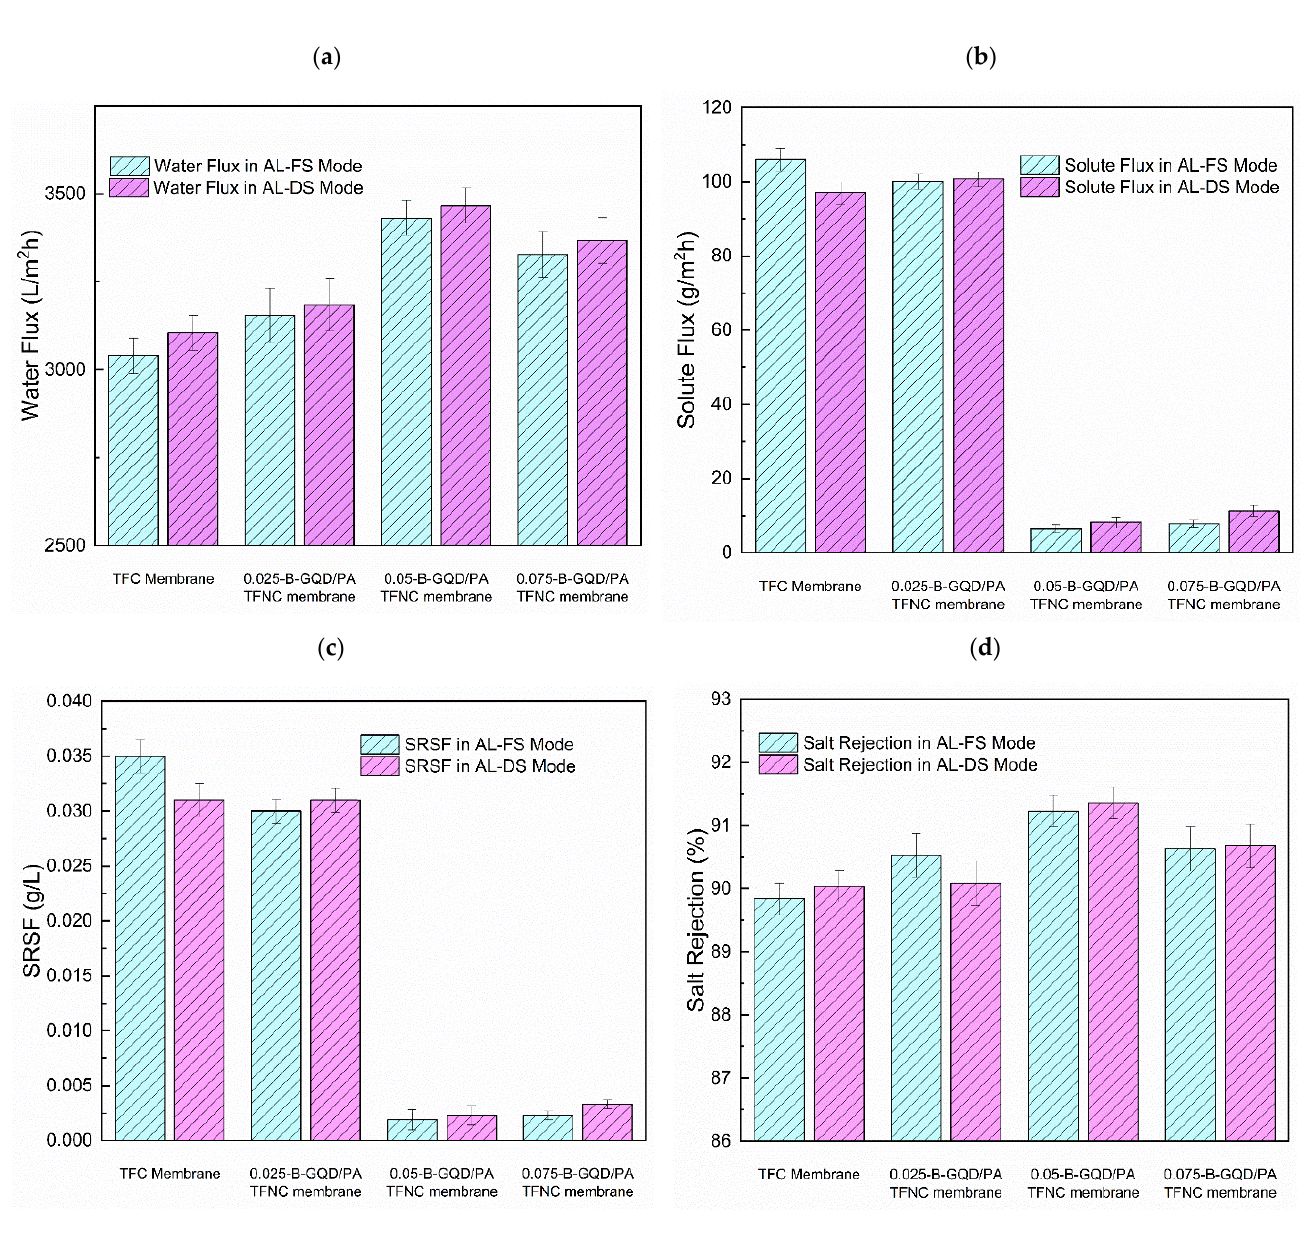
Figure 10. ( a ) Water flux of the TFC and TFNC membranes in the AL-DS and AL-FS orientations at varying B-GQD concentrations; ( b ) salt flux of the TFC and TFNC membranes in the AL-DS and AL-FS membrane orientations at varying B-GQD concentrations; ( c ) SRSF of the TFC and TFNC membranes in the AL-DS and AL-FS membrane orientations at varying B-GQD concentrations; ( d ) salt rejection of the TFC and TFNC membranes in both membrane orientations at varying B-GQD concentrations.